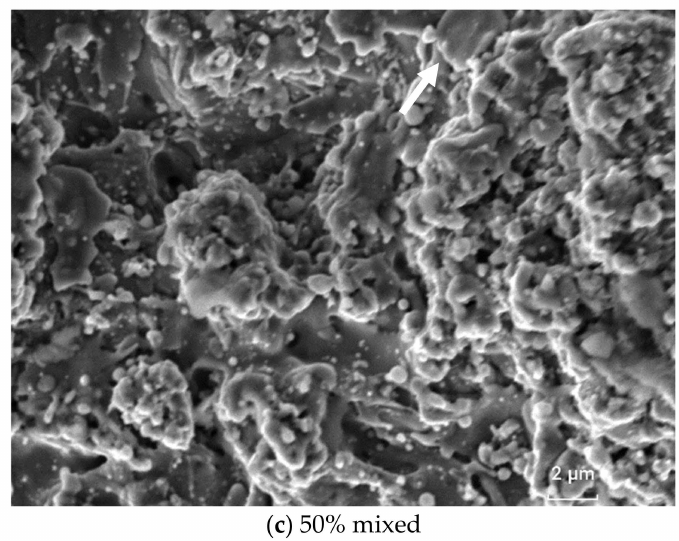
Figure 8. SEM images of the coating surface made from ( a ) HEM-milled spray powder, ( b ) original, and ( c ) 50% mixed spray powder. The surfaces are without any machining steps. The white arrow denotes carbide